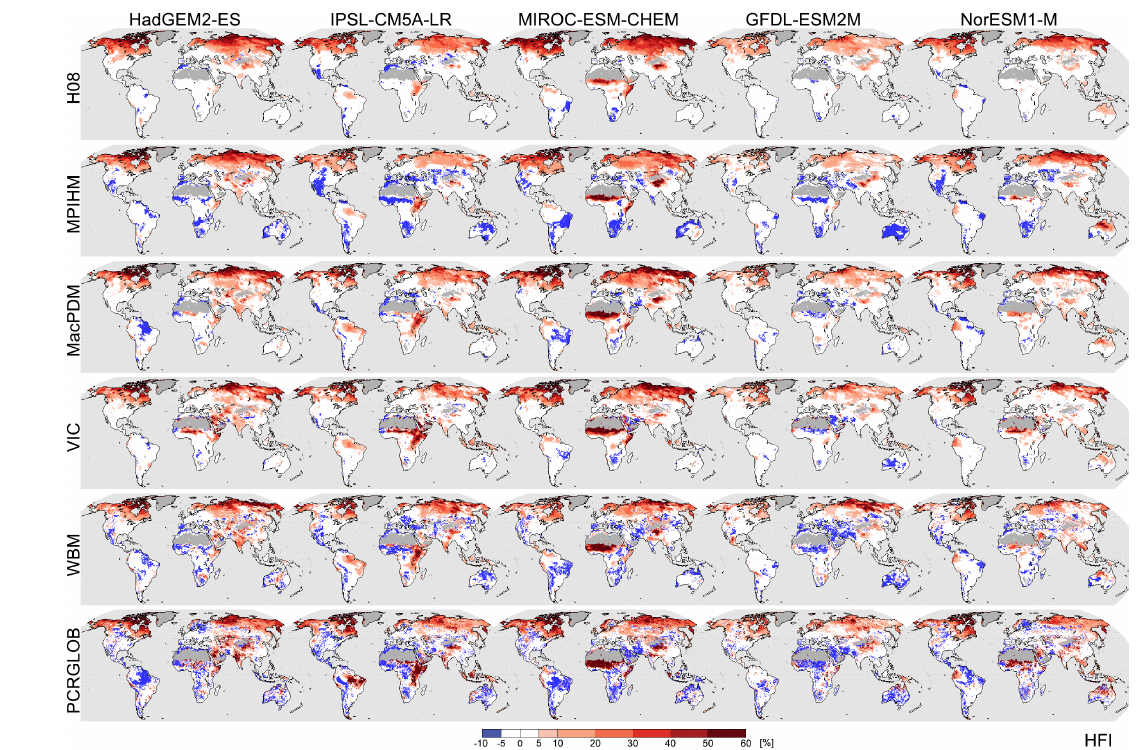
Figure B2. As Fig. 1a, for individual GHM (row) and GCM (column) combination, for HFI.